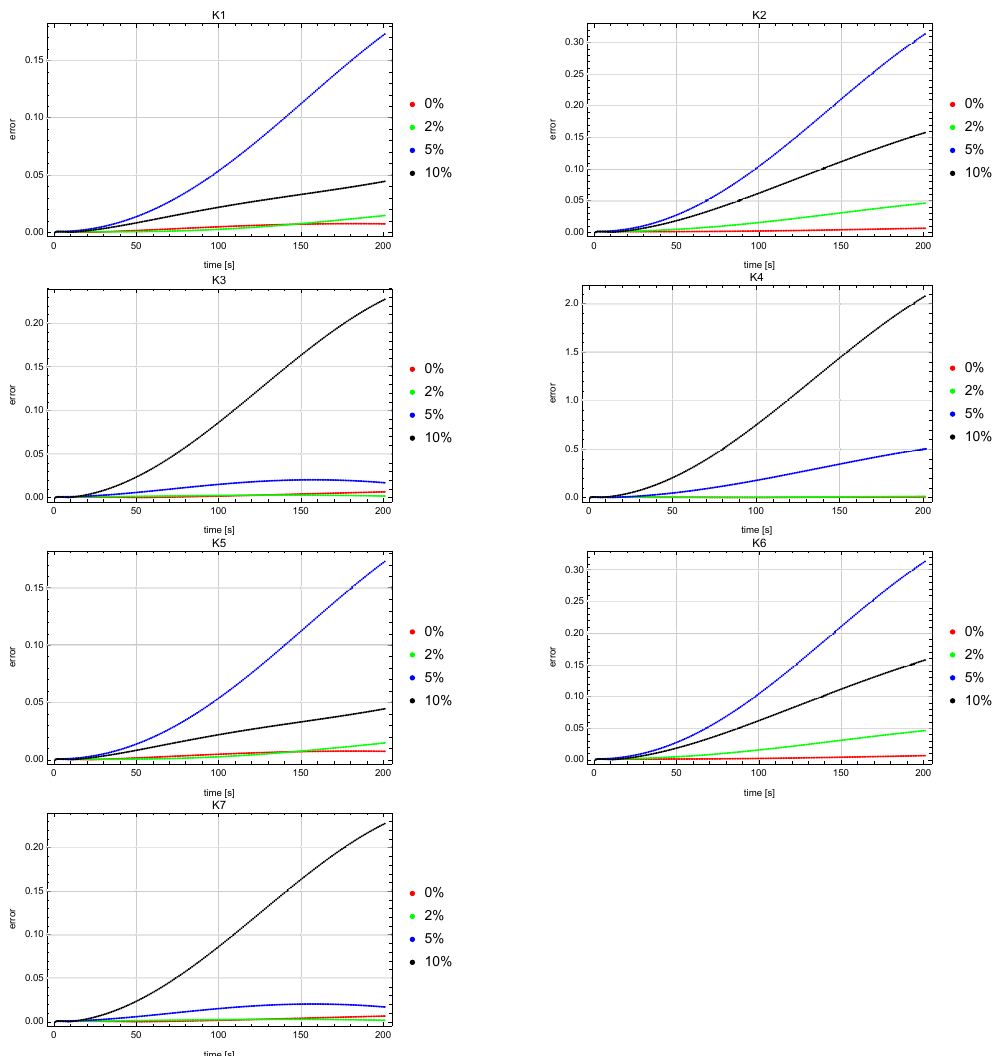
Figure 5. Errors of reconstruction of u state function in points K 1, K 2, K 3, K 4, K 5, K 6, K 7 for HJ